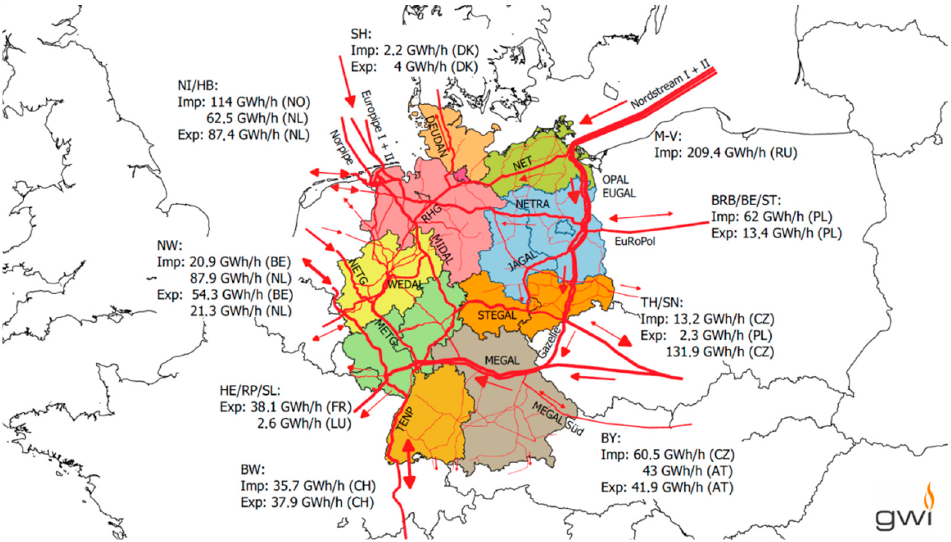
Figure 3. Simplified representation of the gas transportation network in the ten investigated model regions and assumed interconnection capacities to the neighbouring countries and regions used as start values for the REMix model calculations.